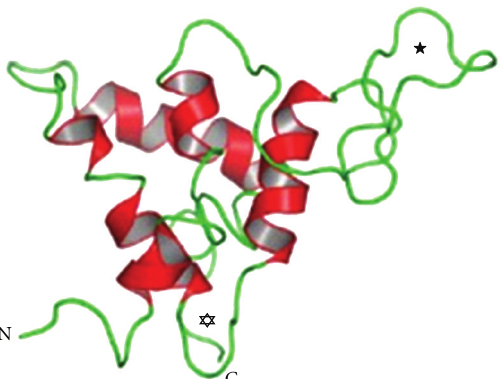
Figure 2: Ribbon diagram of Ara h 2 [26].